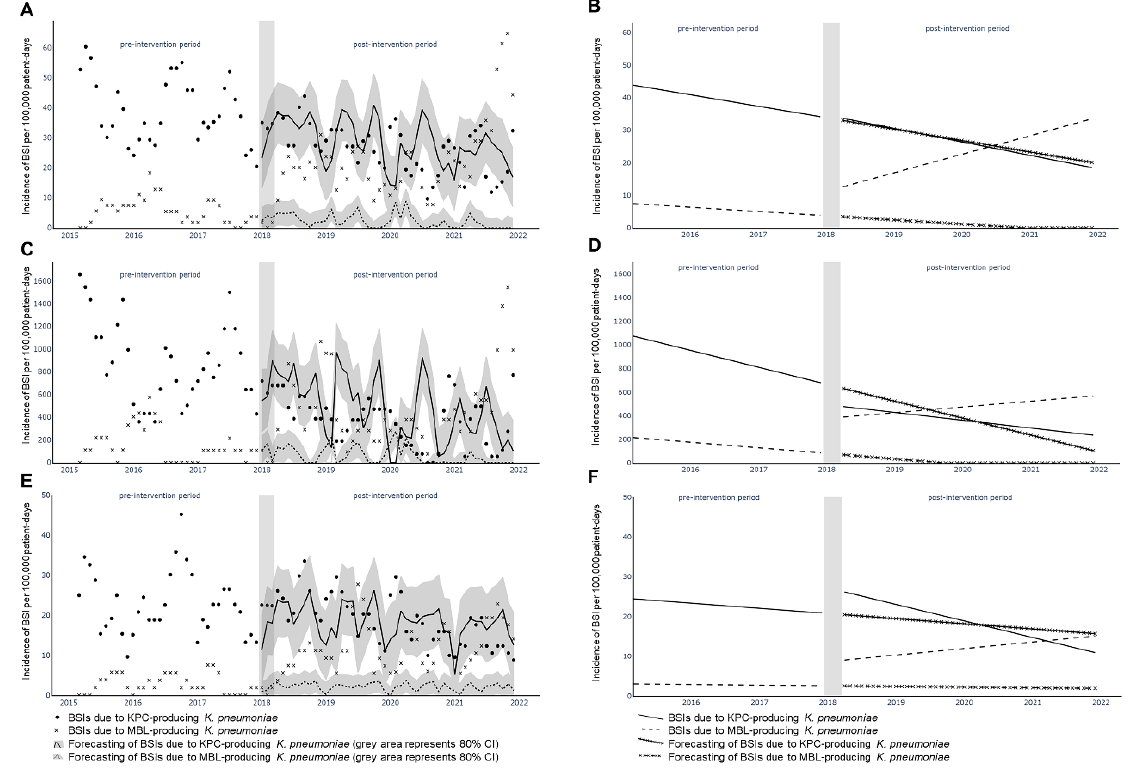
Figure 2. Interrupted time-series analysis of changes in trends of incidence of KPC- and